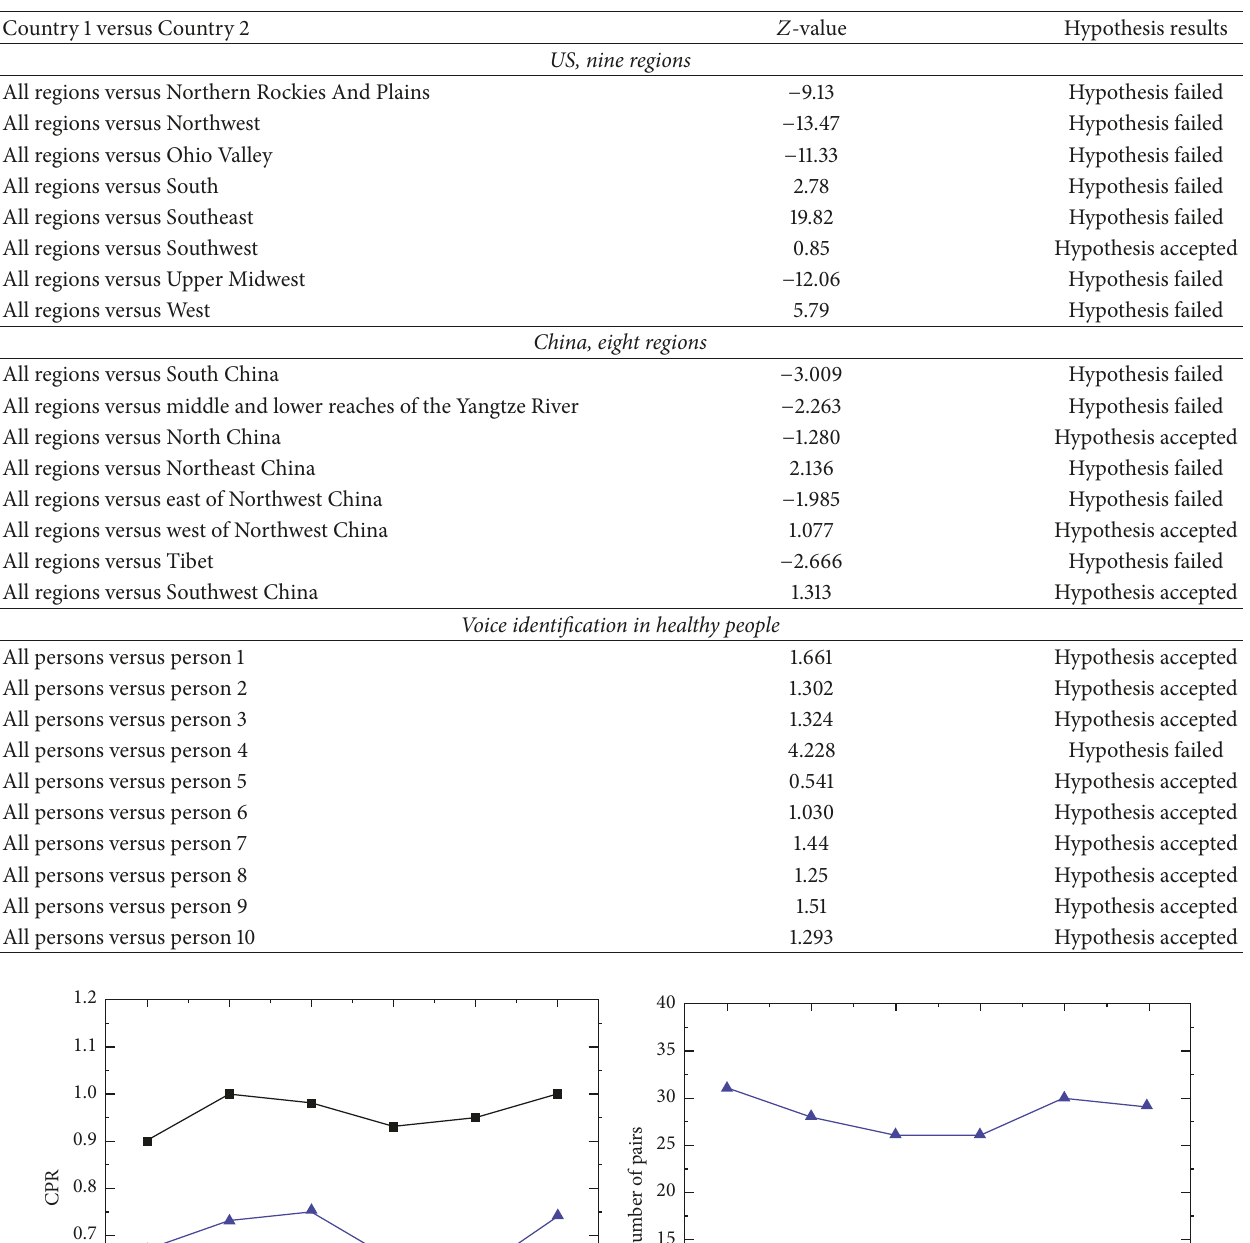
Table 8: Multiple group comparison.